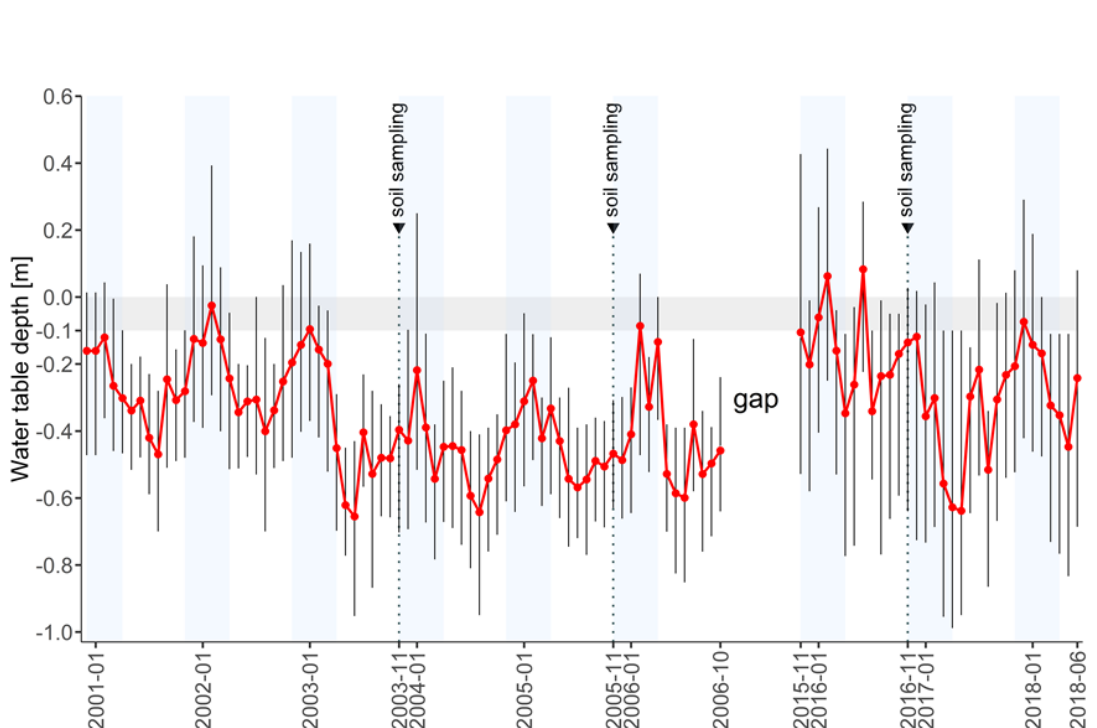
Figure 2. Trend of monthly mean WTD (red dots) and min-max WTD (black vertical bars) of the study fields. The light blue shaded sections show the winter season with blocked ditches (November to